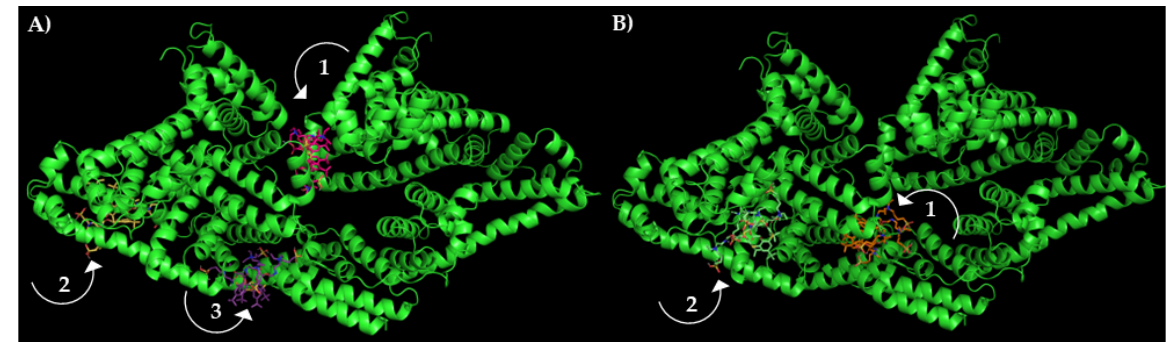
Figure 4. Circular dichroism spectra of ( A ) BSA (3.3 × 10 − 7 M) and the associate of 3 (3.3 × 10 − 6 M) with BSA (3.3 × 10 − 7 M) in buffer at pH 7.4; ( B ) BSA (3.3 × 10 − 7 M) and the associate of 4 (3.3 × 10 − 6 M) with BSA (3.3 × 10 − 7 M) in buffer at pH 7.4.